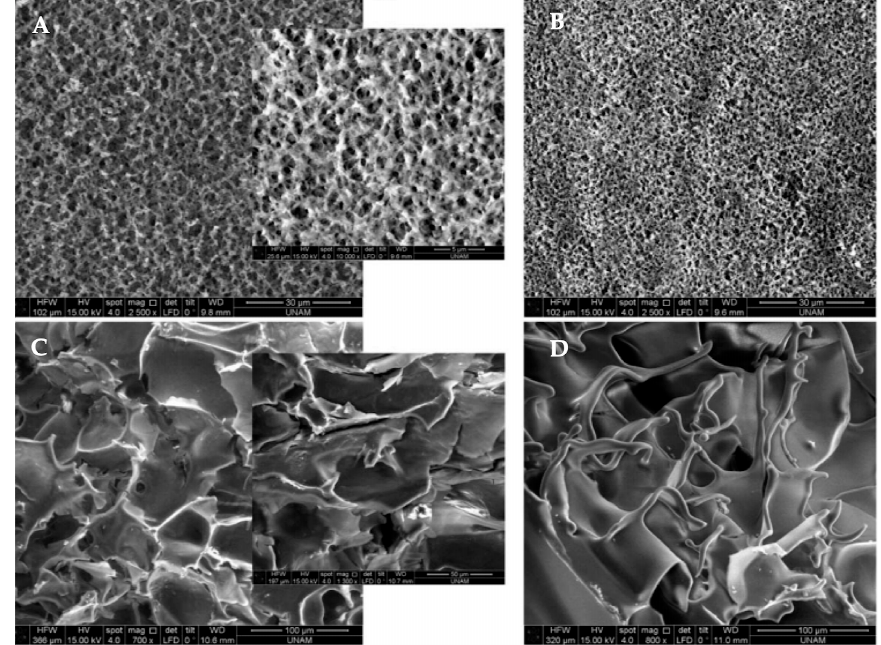
Figure 3. Scanning electron microscope images of ( A ) cadmium (II)-imprinted, ( B ) nonimprinted, ( C